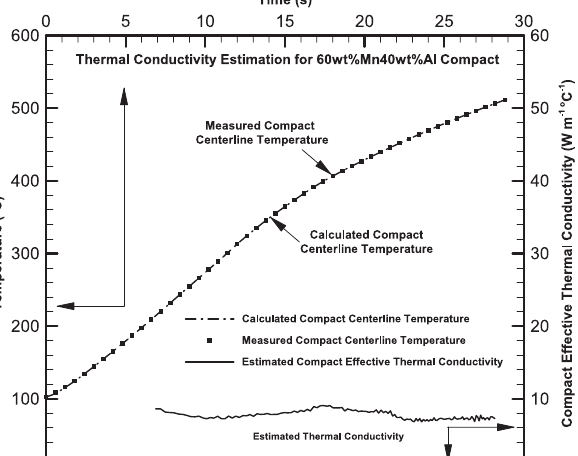
Fig. 14: Estimated Thermal Conductivity of a 50wt%Mn50wt%Al Compact